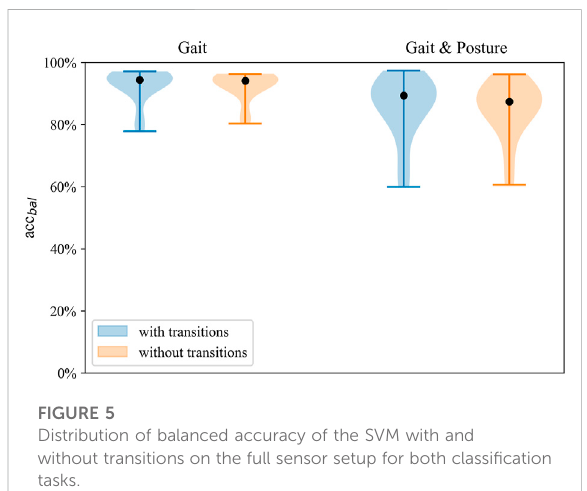
FIGURE 5 Distribution of balanced accuracy of the SVM with and without transitions on the full sensor setup for both classi fi cation